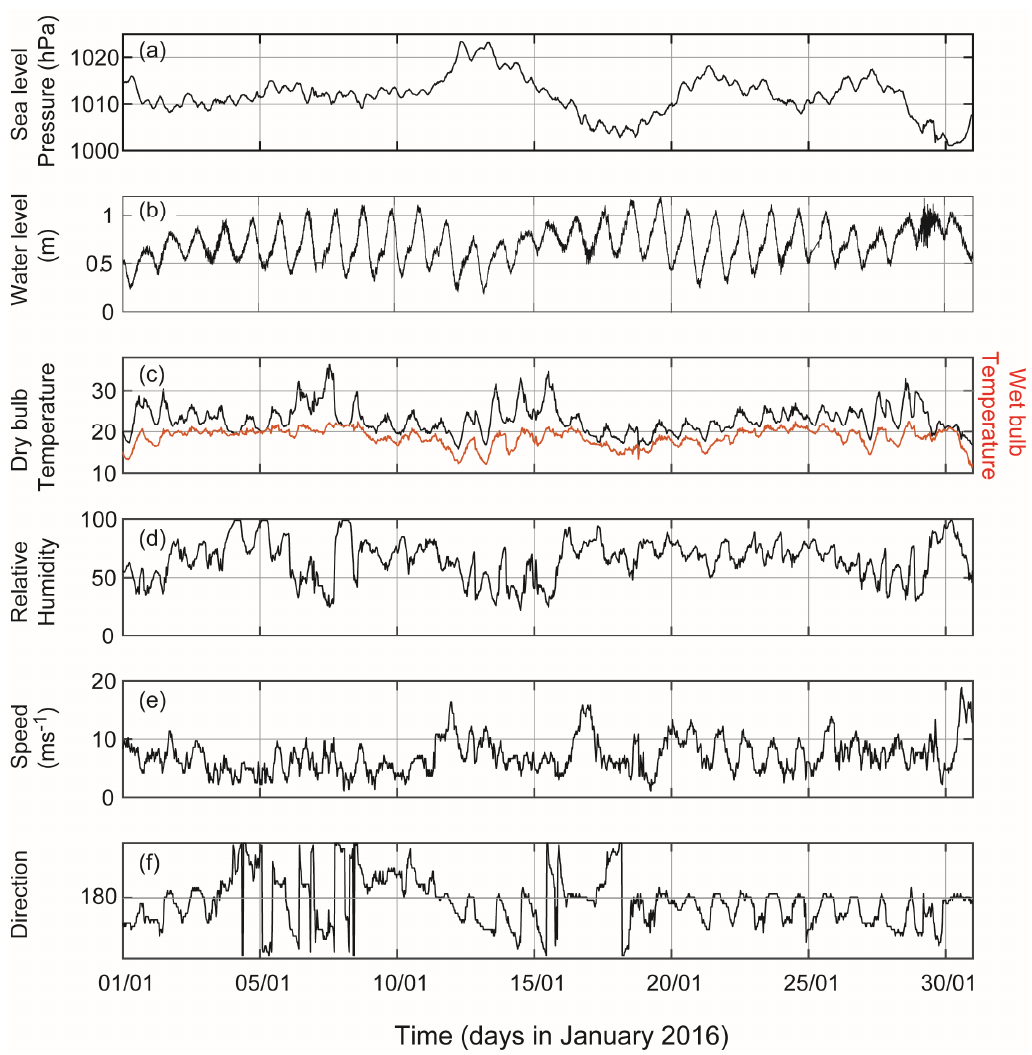
Figure 5. Time series meteorological parameters and water level in January 2016 from Rottnest meteorological station: ( a ) mean sea level pressure; ( b ) water level at Hillarys boat harbour relative to Australian Height Datum (AHD); ( c ) dry and wet bulb temperature; ( d ) humidity; ( e ) wind speed; and, ( f ) wind direction. Meteorological convention is used for wind direction.